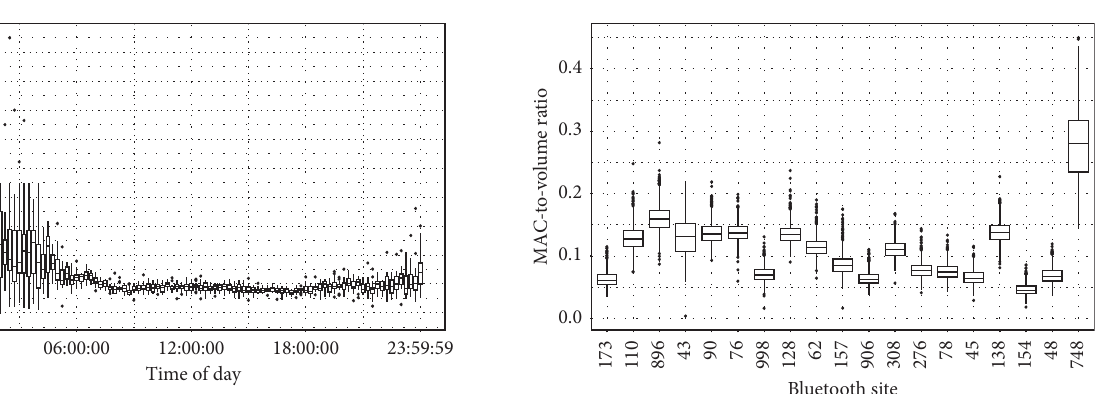
Figure 8: The box-plot of MAC-to-volume ratio of 19 BMSs along Canning Hwy.